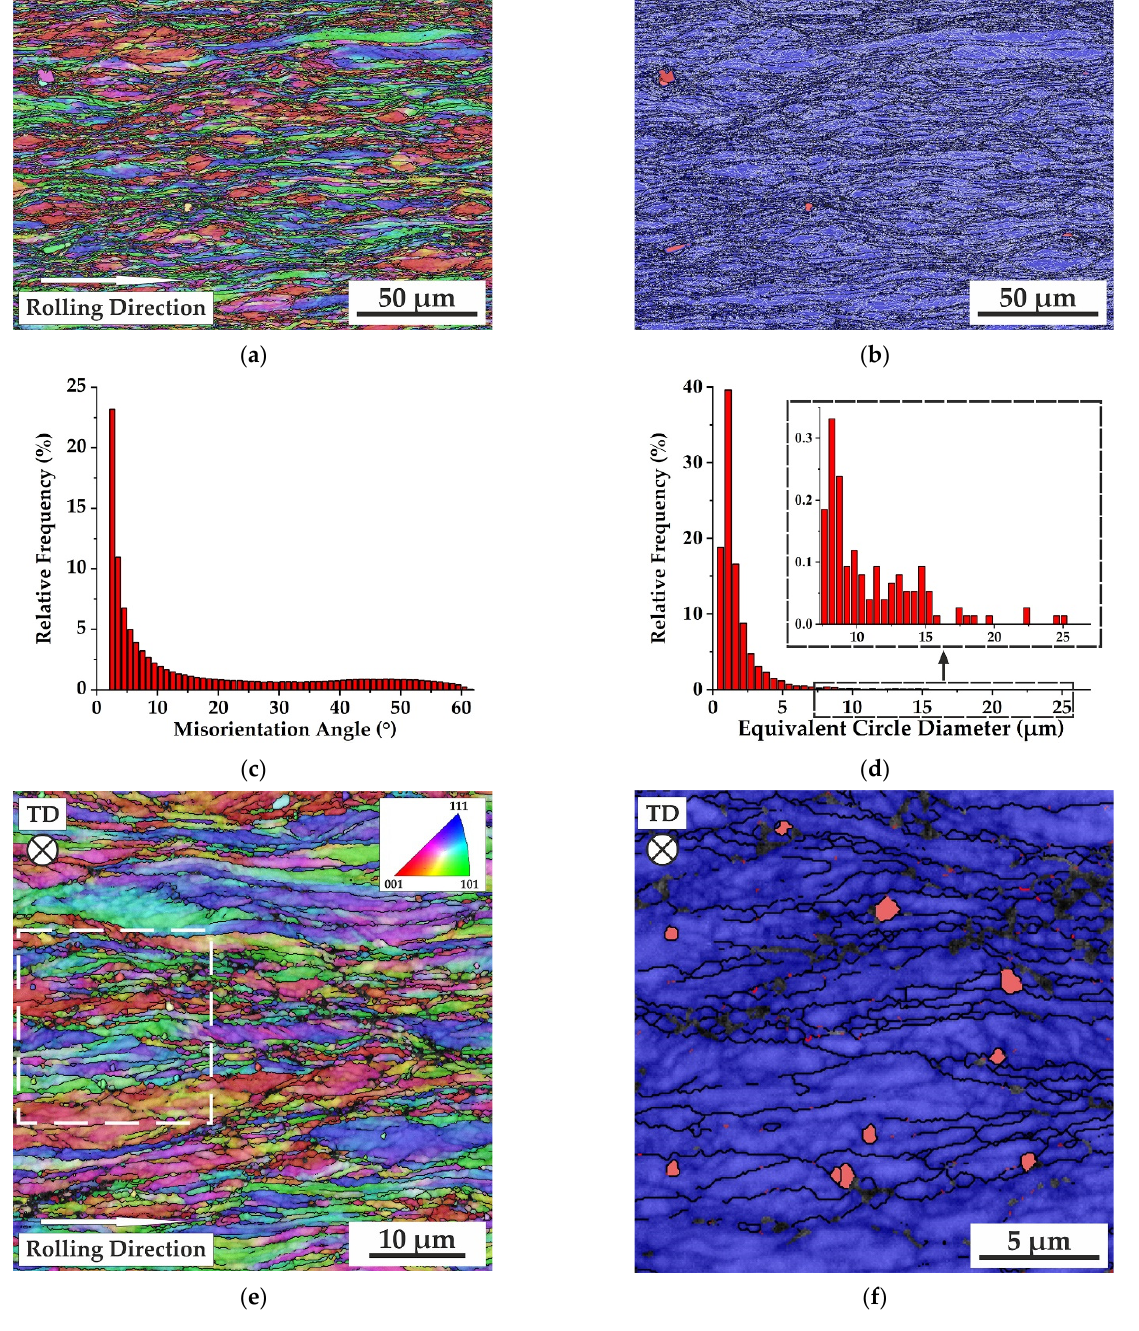
Figure 5. SEM EBSD images of steel microstructure after HTMT-3 in the section perpendicular to transverse direction (TD). Orientation map ( a ), phase map, where austenite is in blue color, carbides is in red color with high-angle and low-angle misorientation boundaries denoted by black and white lines, respectively ( b ), grain misorientation distribution ( c ), grain size distribution ( d ), orientation map ( e ), phase map with the area of the structure marked on ( e ) image by a dashed-line square ( f ). Austenite is in blue color, carbides is in red color with high-angle boundaries denoted by black lines.